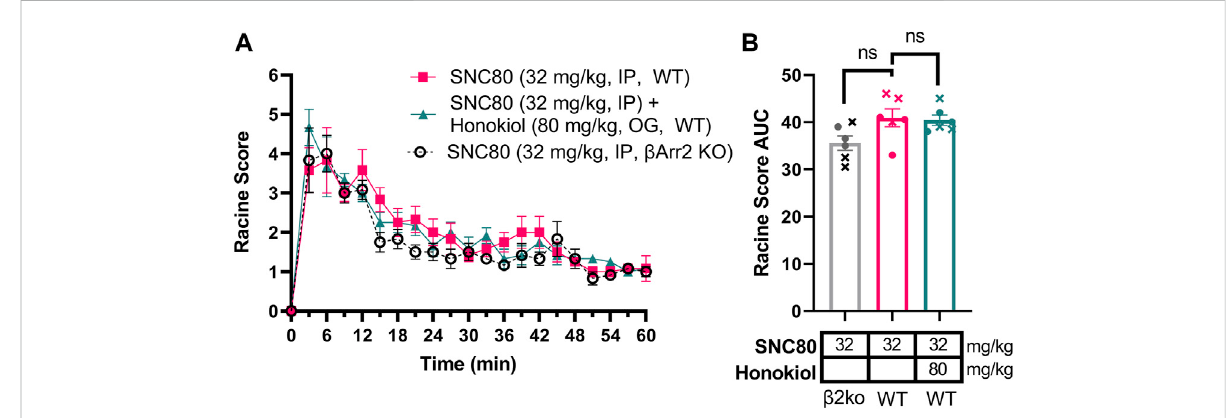
FIGURE 6 Strongerseizuresinducedby32mg/kgSNC80inwild-typemicearenotreducedbyhonokiolandsimilarin β -arrestin2knockoutmice.Seizure activity over time (A) and as area under the curve (AUC) (B) in β -arrestin 2 KO or wild-type mice exposed to SNC80 (32 mg/kg, i.p.), or 32 mg/kg SNC80 and 80 mg/kg honokiol. [n = 6 (3 female and 3 male) in wild-type mice]. In (B) male mice are depicted with a cross, whereas female mice are depicted as circles.